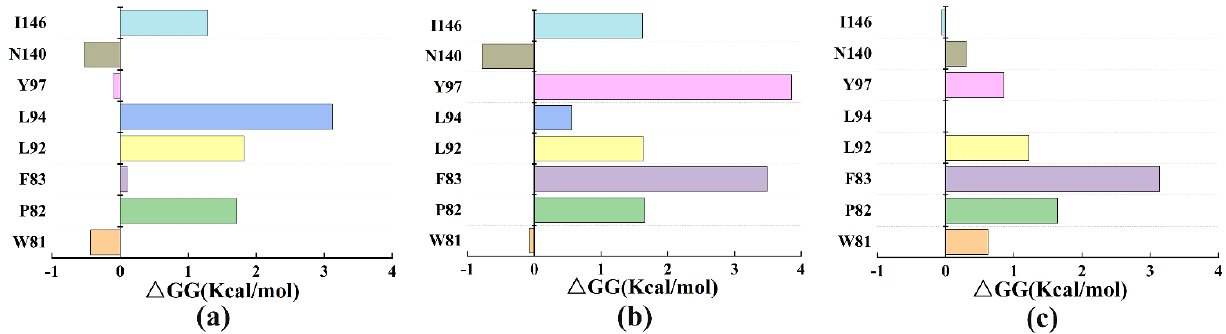
Figure 10. Computational alanine scanning of the active site residues in three complexes. ( a ) BRD4- Cpd4; ( b ) BRD4-Cpd9; ( c ) BRD4-Cpd19.